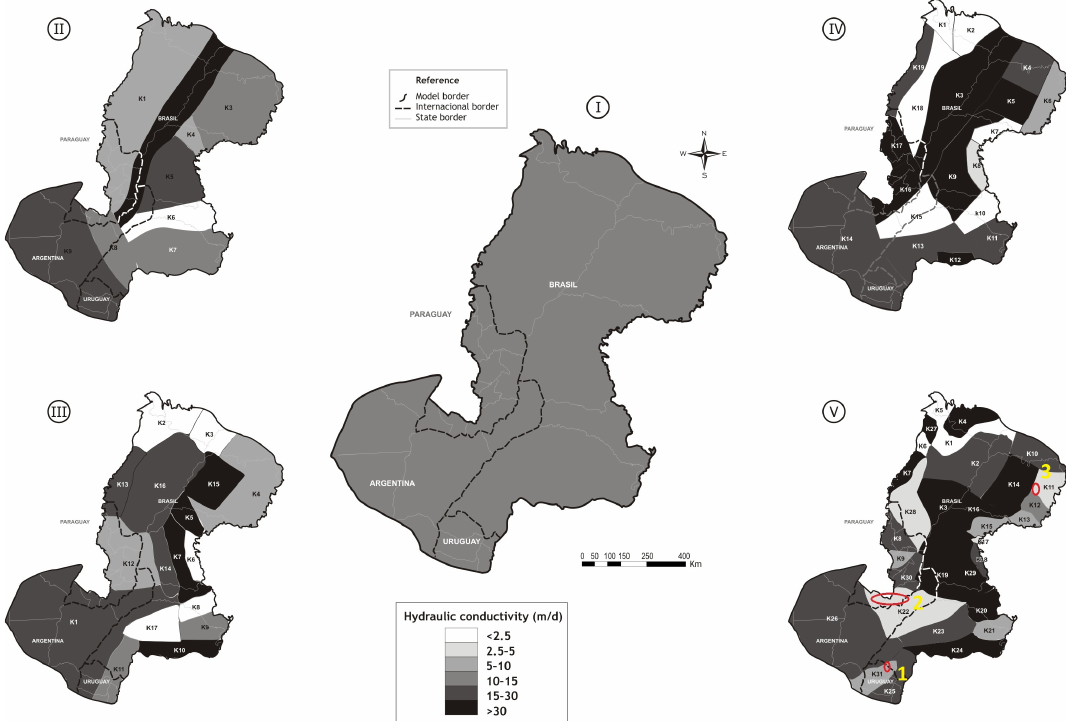
Fig. 11. Calibrated hydraulic conductivity for alternative hydraulic conductivity zonations (yellow numbers on the lower-right map indicate: 1: Rivera/Santana area; 2: southern Paraguay; 3: Riberao-Preto area).